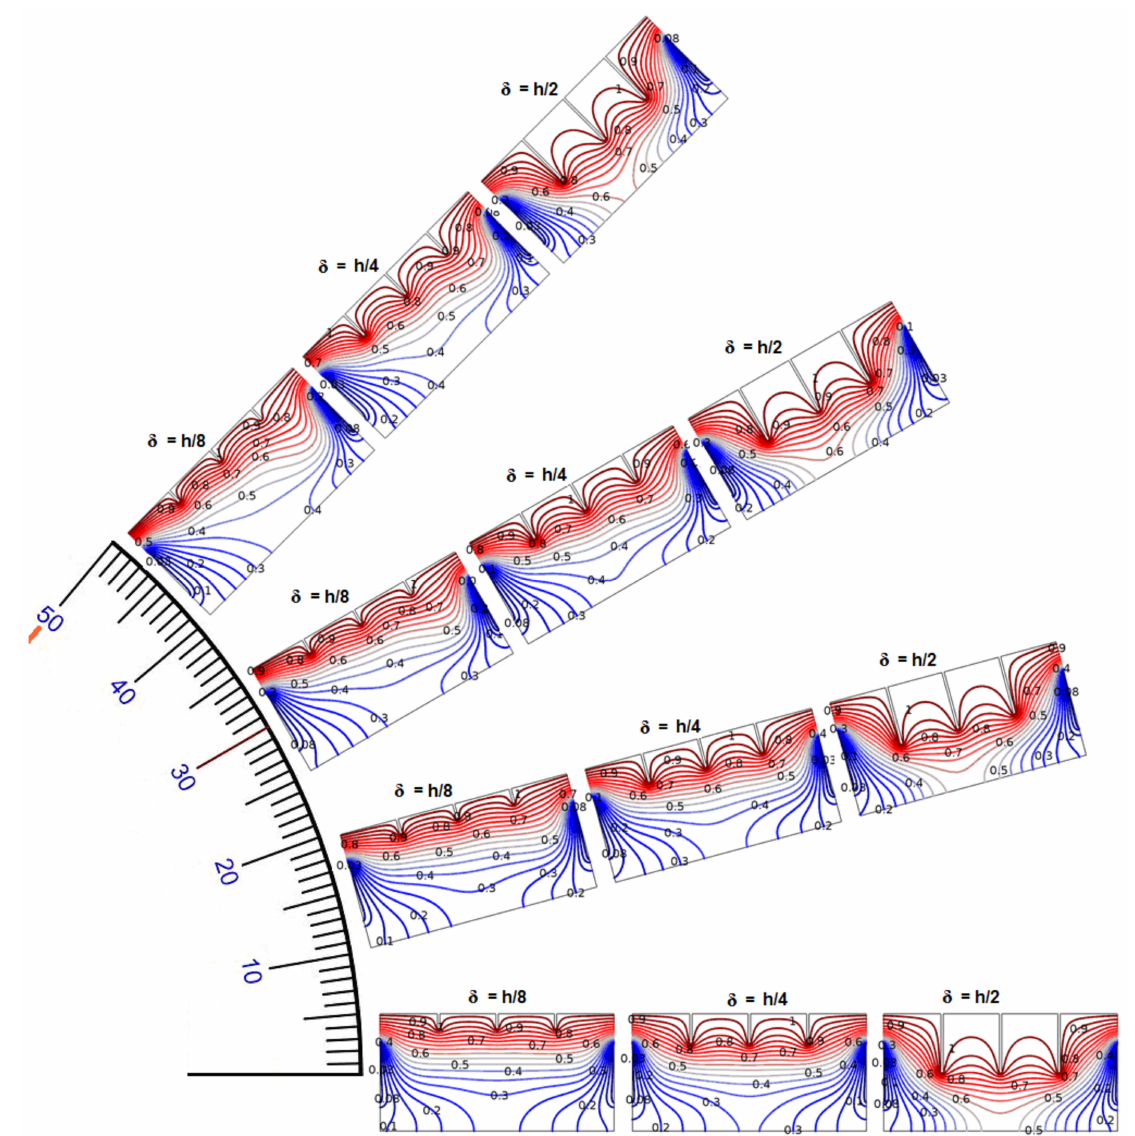
Figure 13. Effects of fins height and enclosure inclination angle on nanofluid